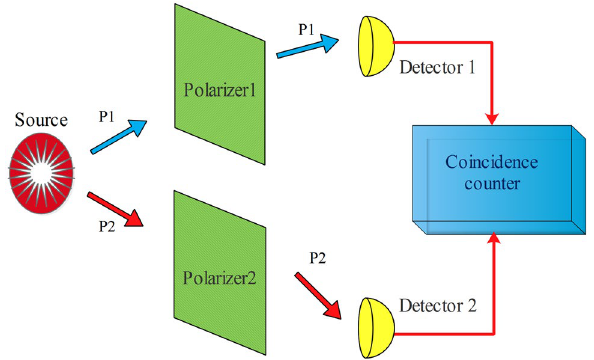
Figure 1. Diagram of a generic Bell test. A source emits pairs of entangled photons. Each photon after passing a one-channel polarizer, which its direction can be set by experimenter, is detected by a detector. Coincidence counter monitors coincidences due to a predefined